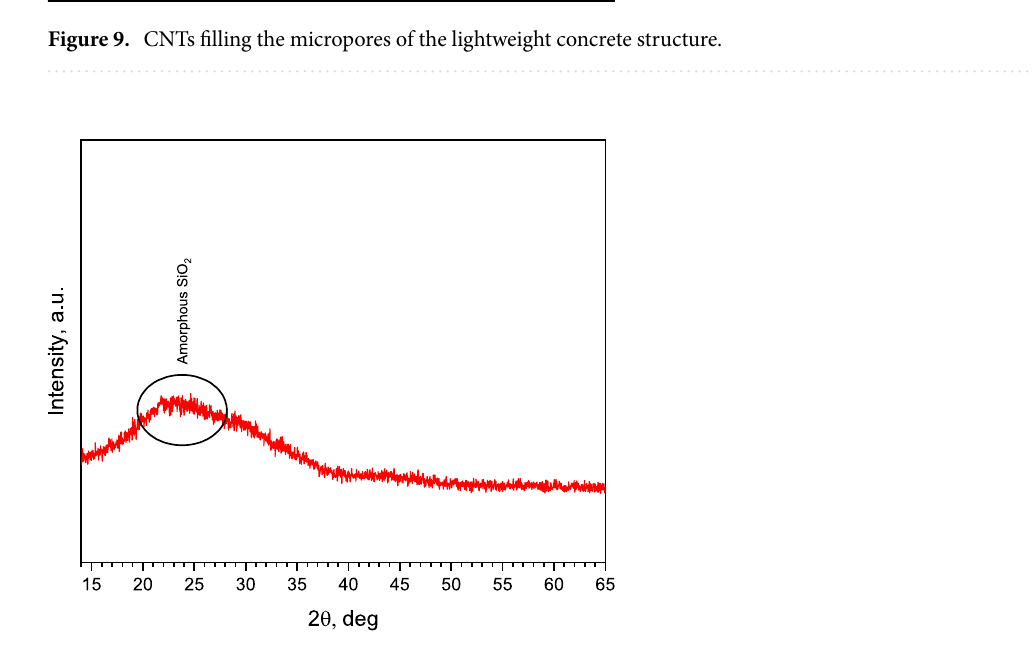
Figure 10. X-ray diffraction pattern of expanded glass